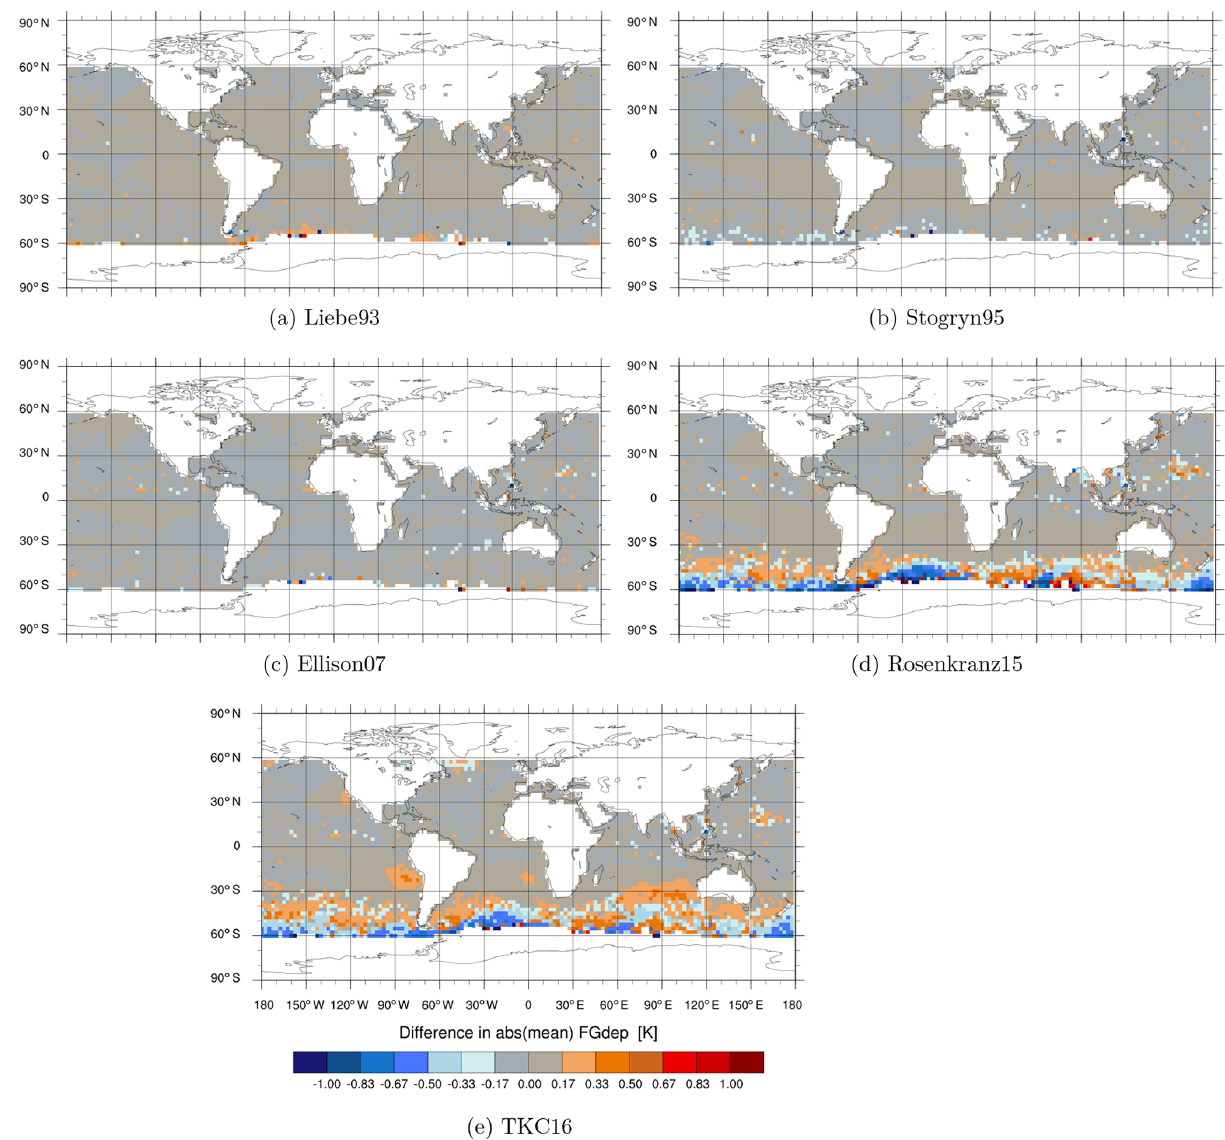
Figure A3. As in Fig. A1 but for channel